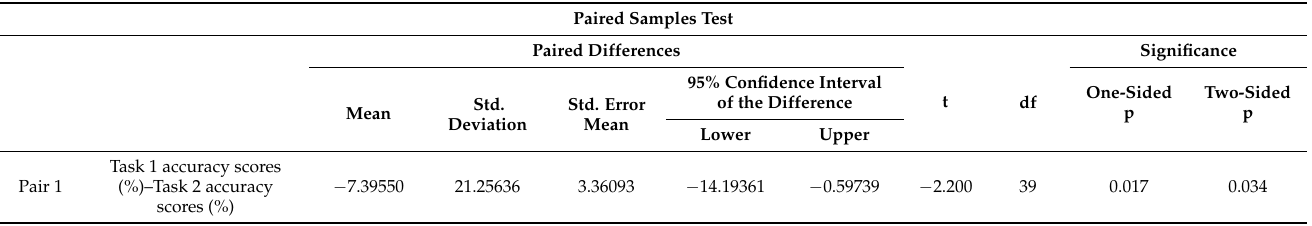
Table A2. Paired Samples Test table.